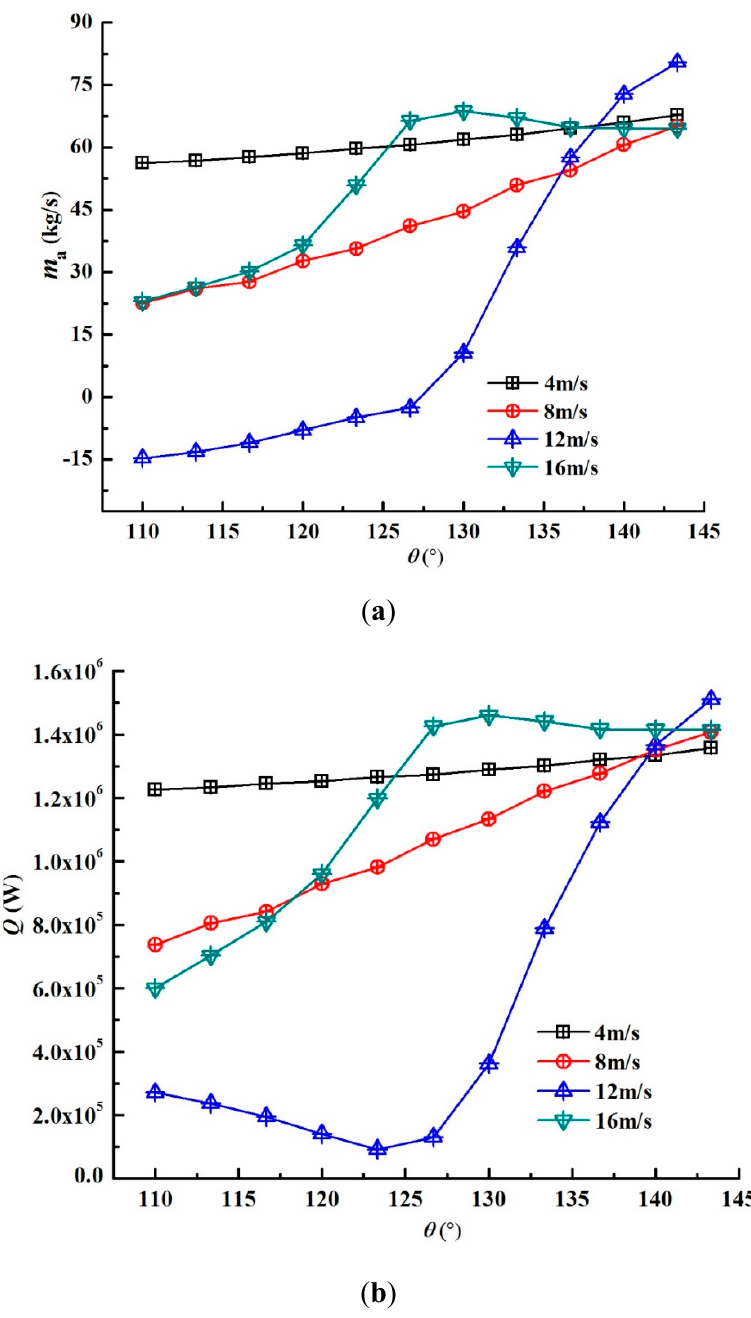
Figure 15. Thermo-flow performances of the middle-rear deltas. ( a ) Air mass flow rate, ( b ) heat rejection.